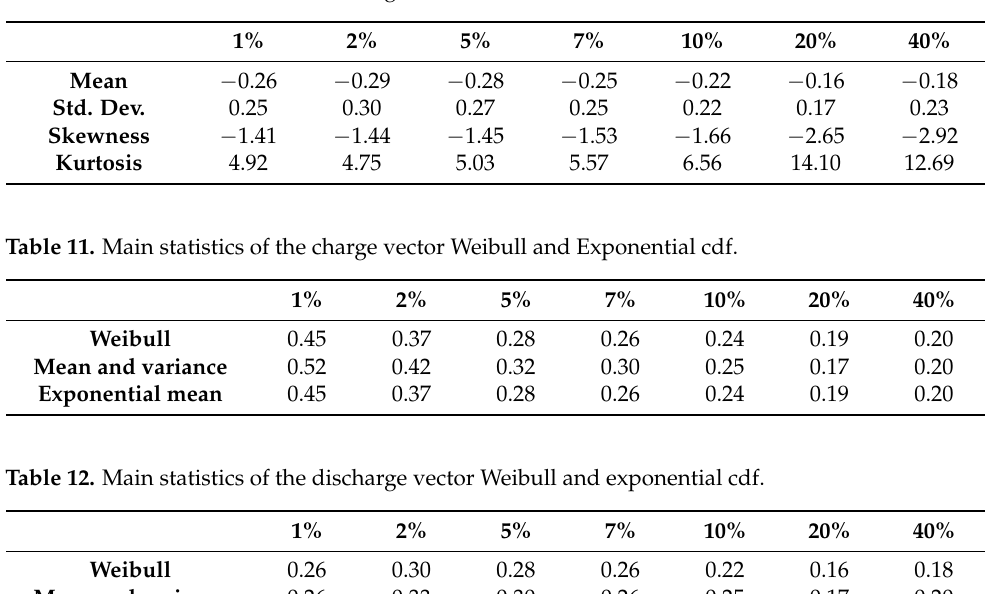
Table 10. Main statistics of the discharge vector ecdf.